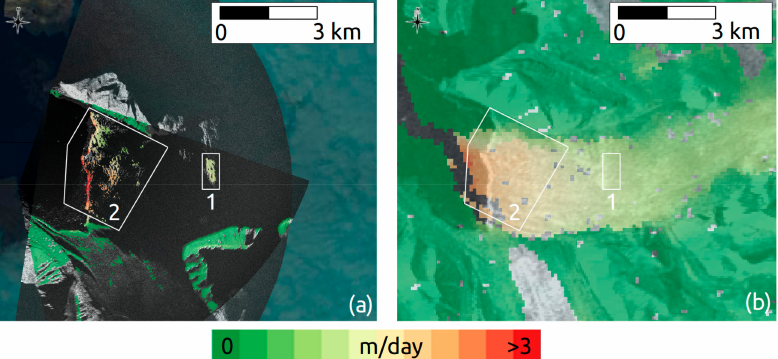
Figure 18. Ice velocity maps over Kronebreen (Svalbard) from GPRI data of 27-08-2016 ( a ) and Sentinel-1 data of 20-08/01-09-2016 ( b ). The two boxes indicate the regions where the inter-comparison in